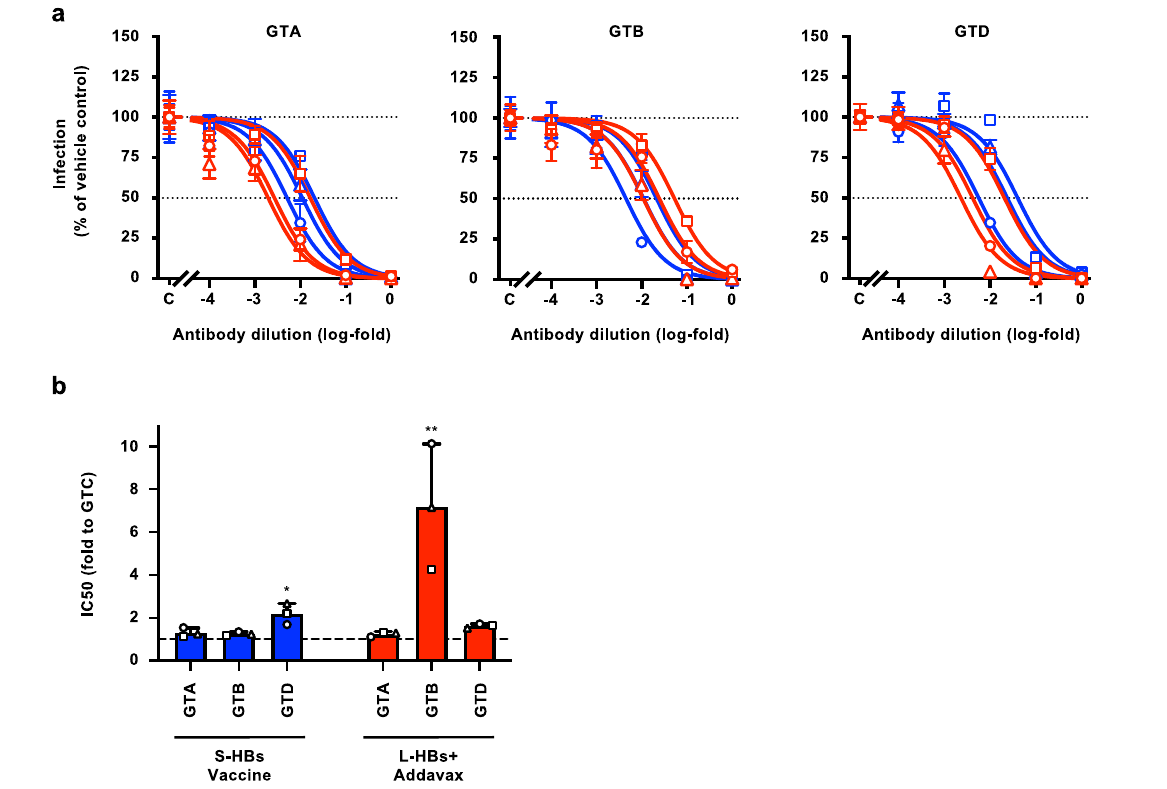
Fig. 5 | Neutralizing activities against HBV strains of various genotypes. a The neutralizing activities of induced antibodies to HBV strains of various genotypes were evaluatedbythe HBV/NLinfectionsystem.The HBV/NLs harboring the L-HBs region of GTA, GTB, and GTD were mixed with serially diluted antibodies from rhesusmacaquesimmunizedwithS-HBsvaccine(blue)orL-HBs+Addavax(red)for 1h at 37°C and infected into G2/NT18-C cells. The infection ef fi ciencies were